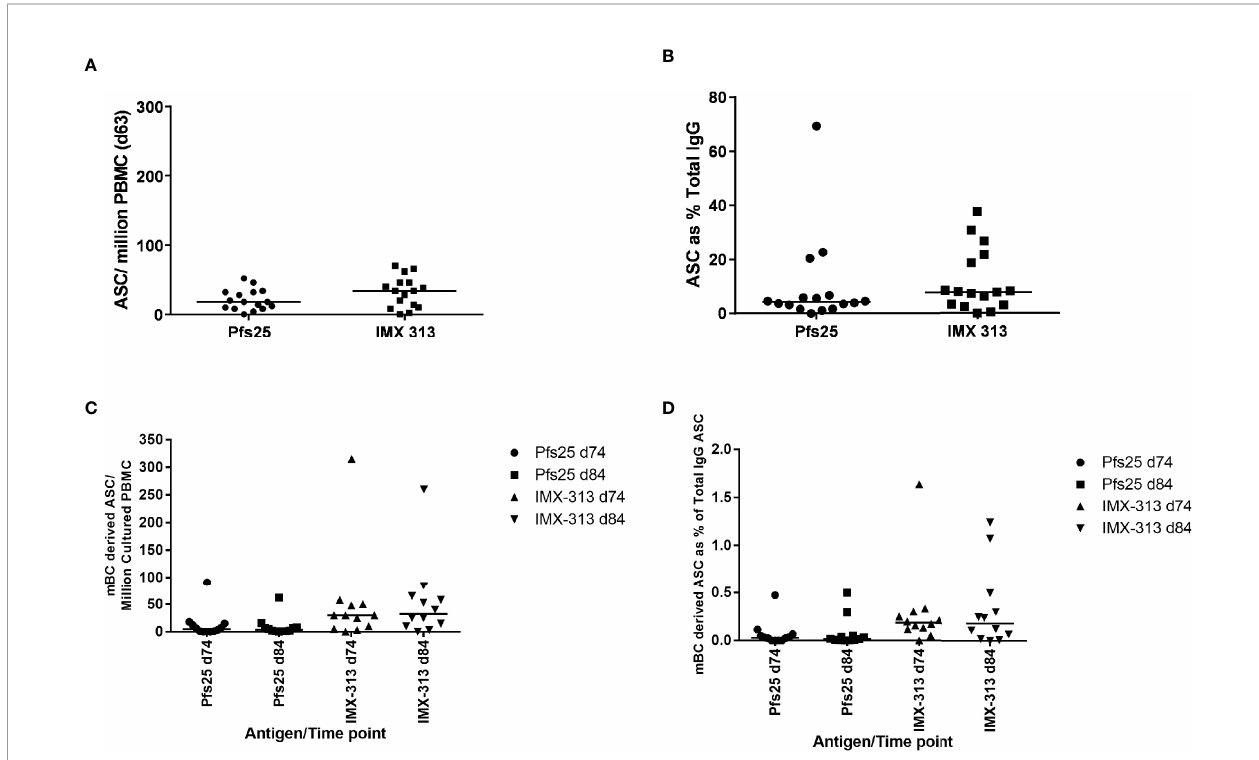
FIGURE 5 | B cell response to vaccination. (A) Pfs25 and IMX313 – speci fi c antibody-secreting cell (ASC) responses were assessed by ex-vivo ELISPOT using Pfs25 and IMX313 proteins and frozen PBMCs from the day 63 time point in Groups 2B and 2C. Individual and median responses are shown for each group and reported as Pfs25 and IMX313 – speci fi c ASCs per million PBMCs used in the assay, or as (B) percentage of total number of IgG-secreting cells. (C) Pfs25 and IMX313 – speci fi c memory B cell (mBC) responses were assessed by ELISPOT assay using Pfs25 and IMX313 proteins. Frozen PBMCs were thawed and underwent a 6-day polyclonal re-stimulation during which ASCs were derived from mBCs, before testing in the assay. Individual and median responses are shown from the day 74 and day 84 time point and are reported as mBC-derived Pfs25 – speci fi c ASCs per million cultured PBMCs or as (D) percentage of total number of IgG-secreting